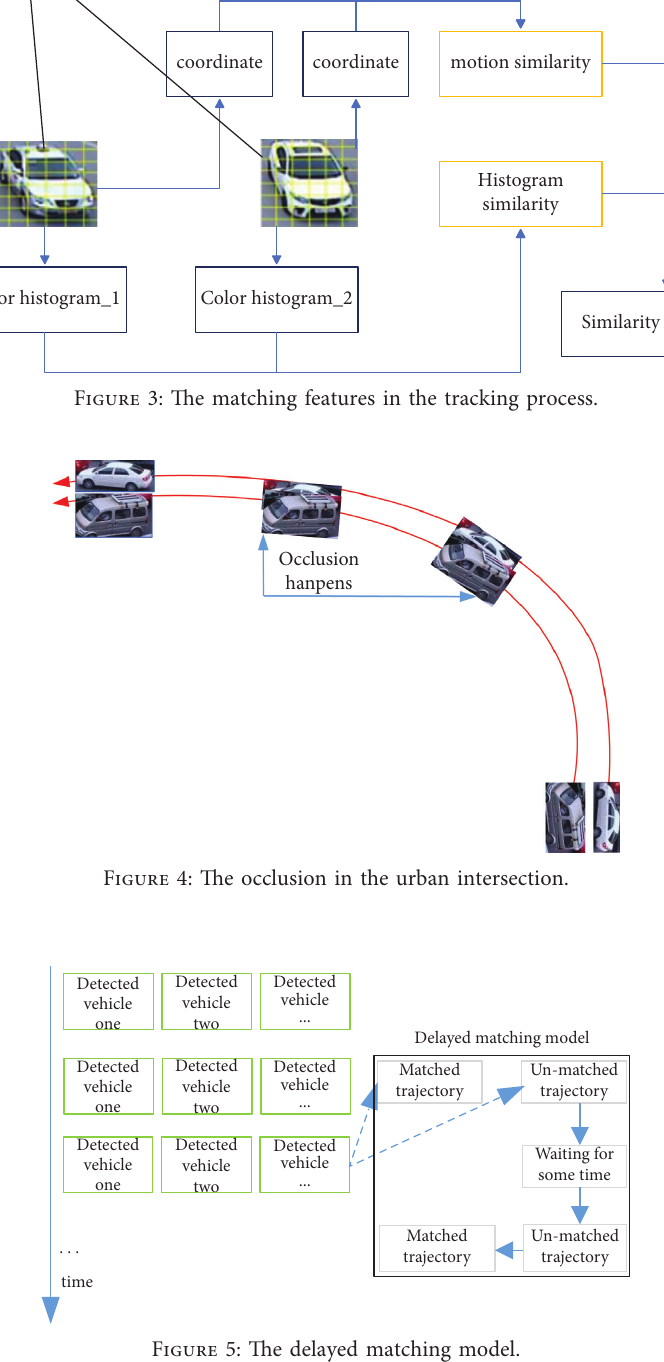
Figure 5: The delayed matching